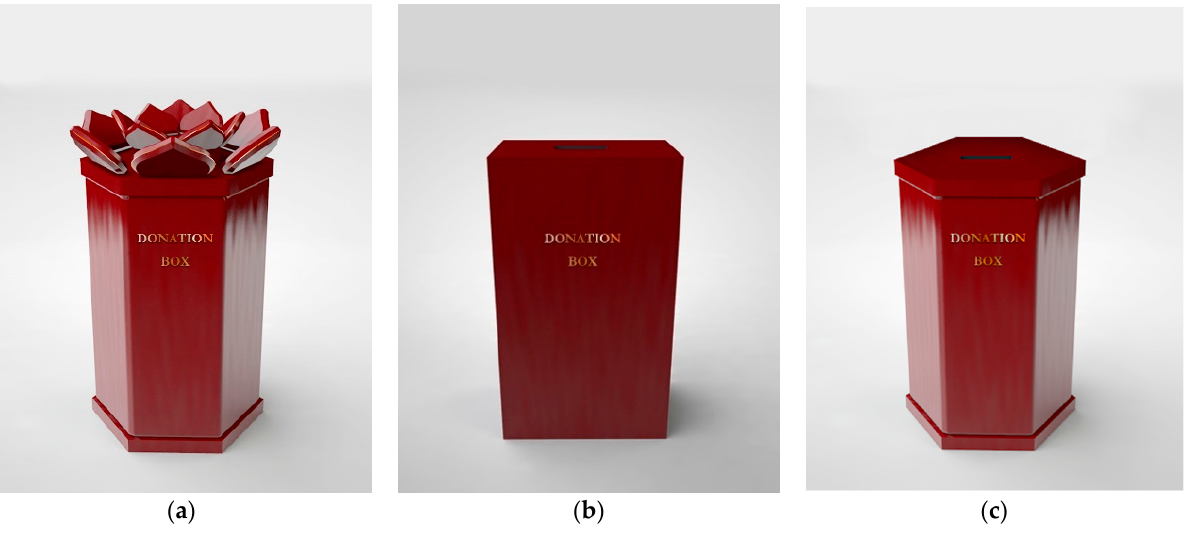
Figure 2. The donation boxes were utilized in the pilot study and main study. ( a ) The donation box with Buddhist symbol design, a lotus symbol arranged on the top; ( b , c ) The donation boxes without Buddhist symbol design.